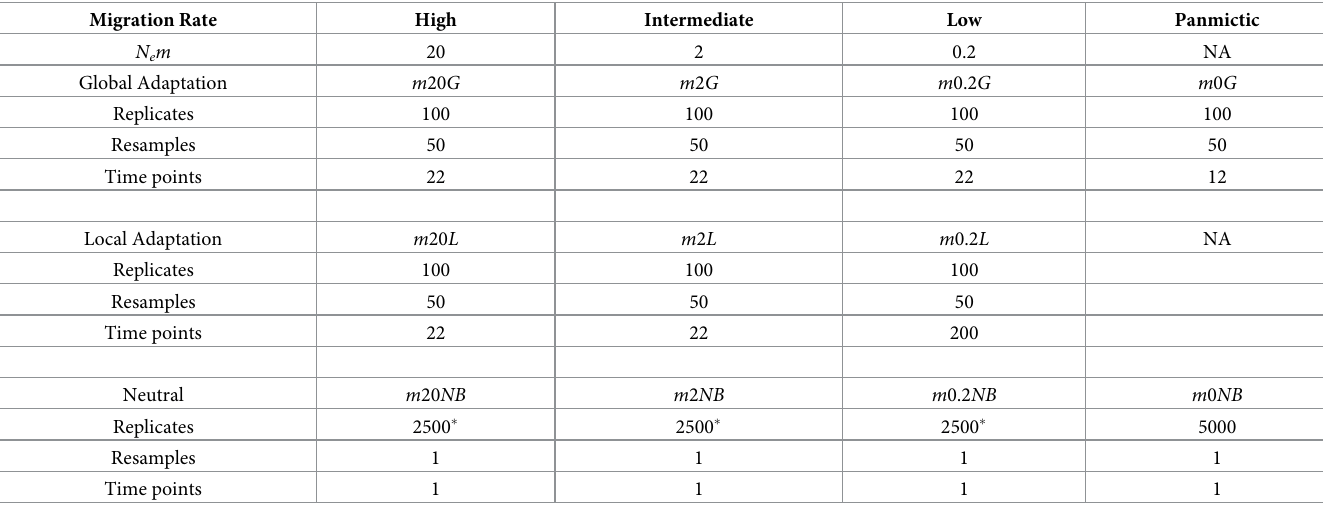
Table 2. All simulation parameters of two deme